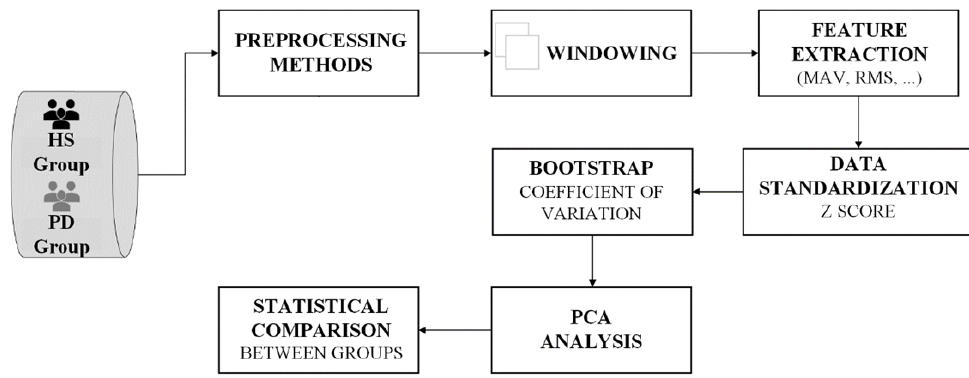
Figure 4. Flow diagram of signal processing.